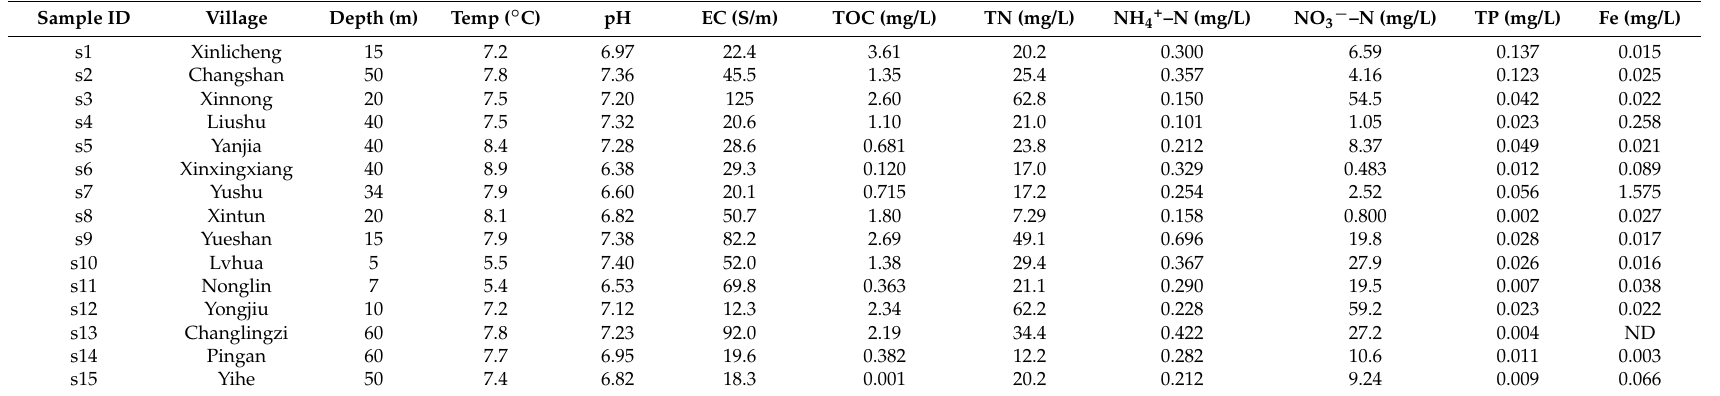
Table 1. Properties of well